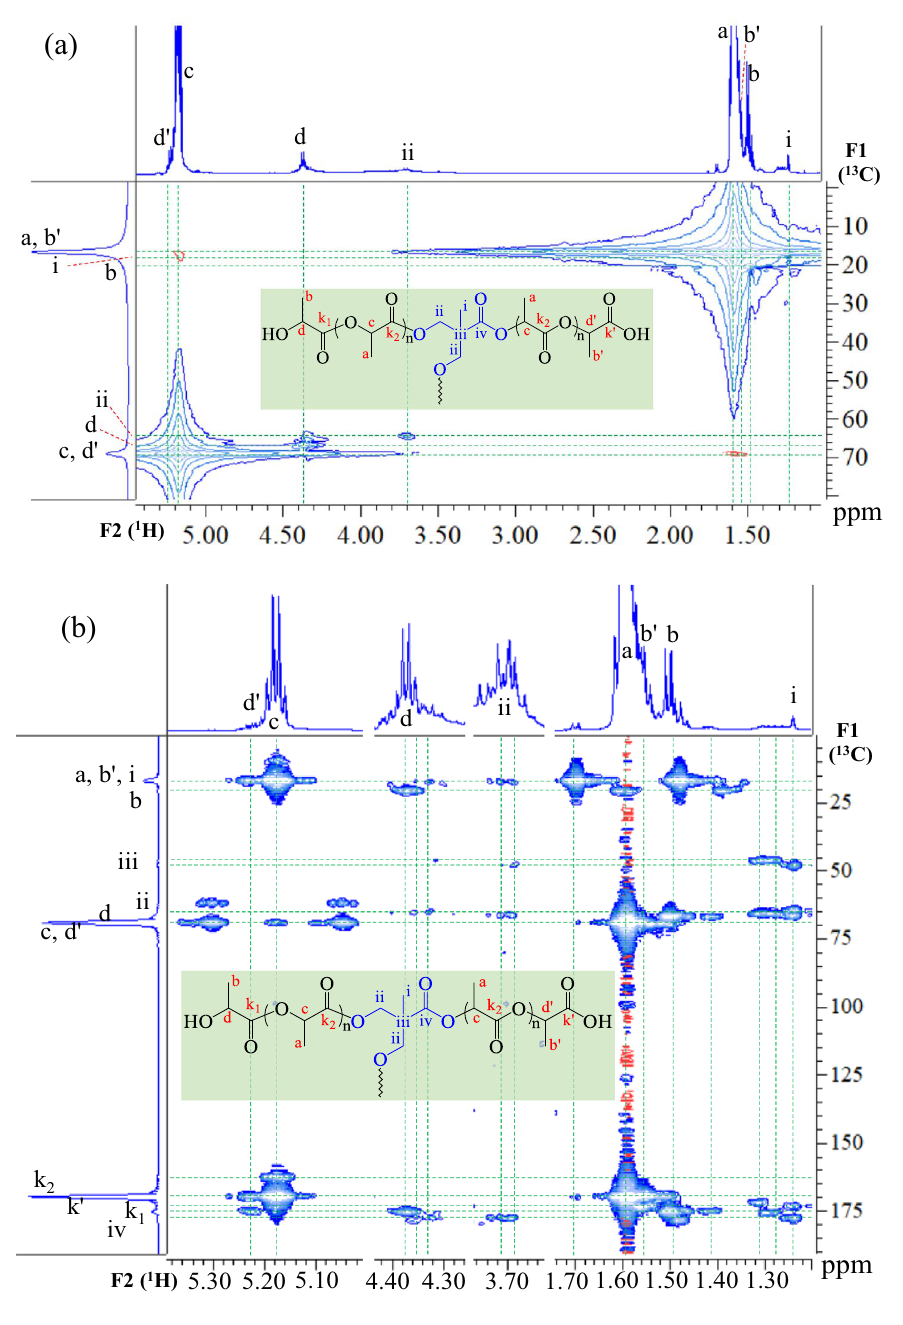
Figure 2. 2D-NMR ( a ) HMQC and ( b ) HMBC correlation plots of